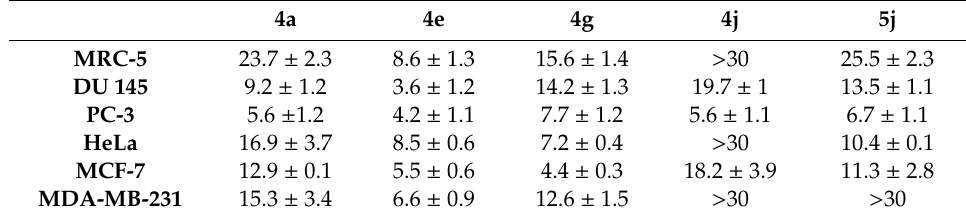
Table 2. IC 50 values (μM ± SD) of the selected compounds determined on various cancer cell lines and on non-cancerous MRC-5 cells .